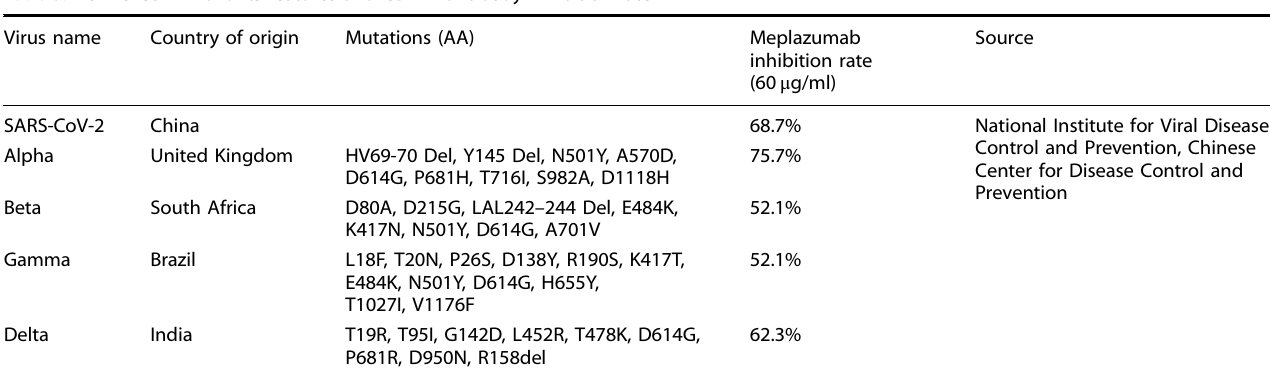
Table 3. SARS-CoV-2 variants features and CD147 antibody inhibition